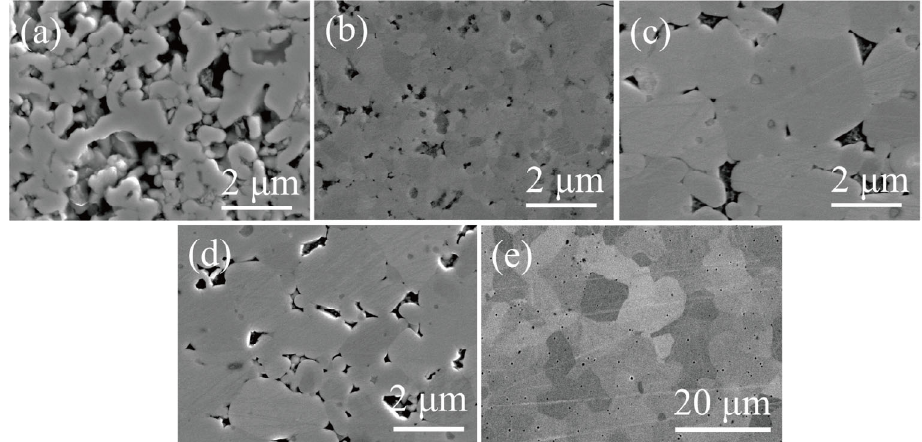
Fig. 5 SEM images of the polished surfaces for the as-sintered specimens: (a) HC1350-L, (b) HC1350-H, (c) HC1550-L, (d) HC1550-H, and (e) H2000.